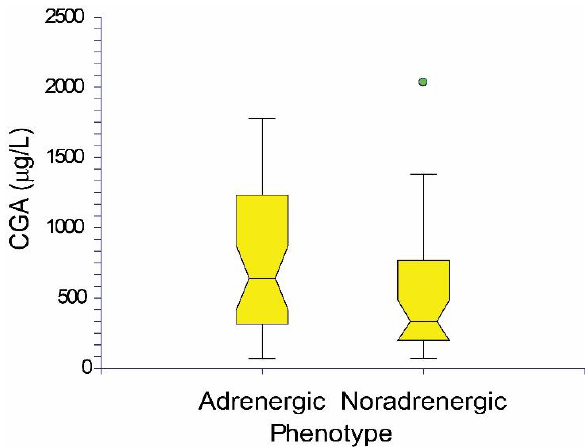
Figure 2. The notched box plot of CGA concentrations in adrenergic and noradrenergic phenotype of PPGL patients.